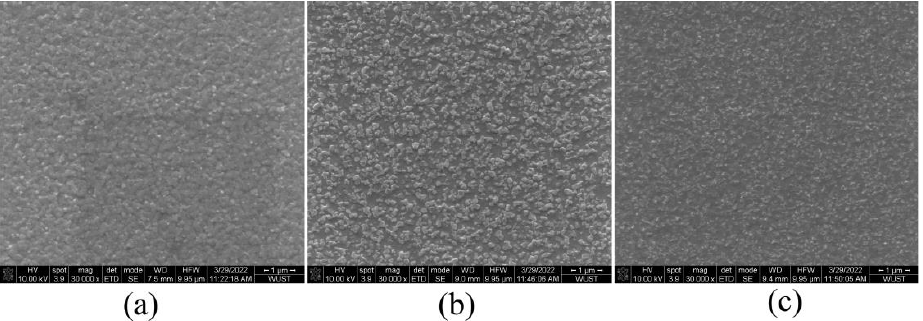
Figure 6. SEM images of perovskite films prepared on PEDOT:PSS/PVK double-layer HTL with ( a ) 0 mg/mL PVK, ( b ) 8 mg/mL PVK, and ( c ) 12 mg/mL PVK. ( a ) 0 mg/mL PVK, ( b ) 8 mg/mL PVK, and ( c ) 12 mg/mL